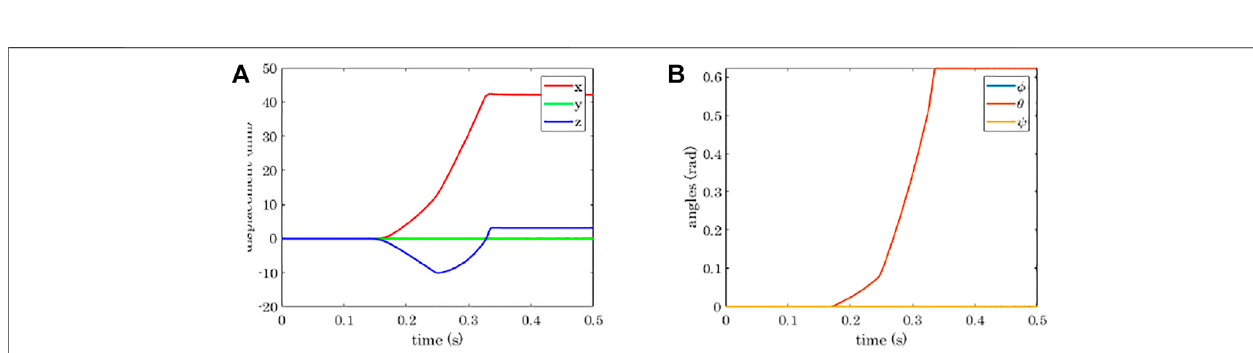
FIGURE11| Powergraspofaspherewiththefour- fi ngeredgripper:positioncoordinatesindicatingtheobjecttranslation (A) ,andEuleranglesindicatingtheobject rotation (B) . ϕ , θ , ψ indicate the rotation around z , y , and x , respectively.